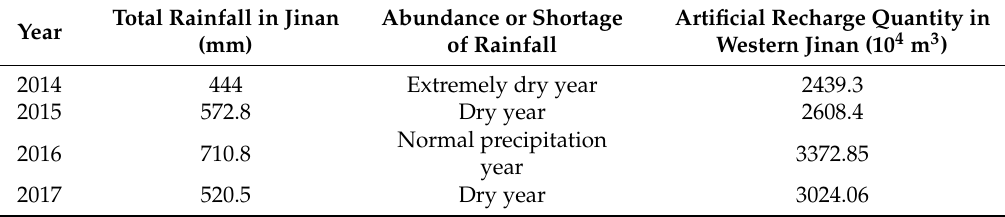
Table 2. Total rainfall and artificial recharge quantity from 2014 to